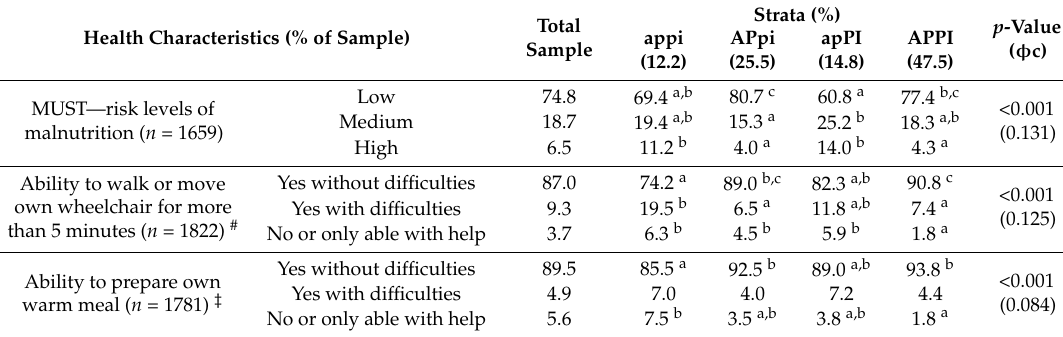
Table 3. Strata profiles based on health characteristics in 1825 adults aged 65 years and older from five European